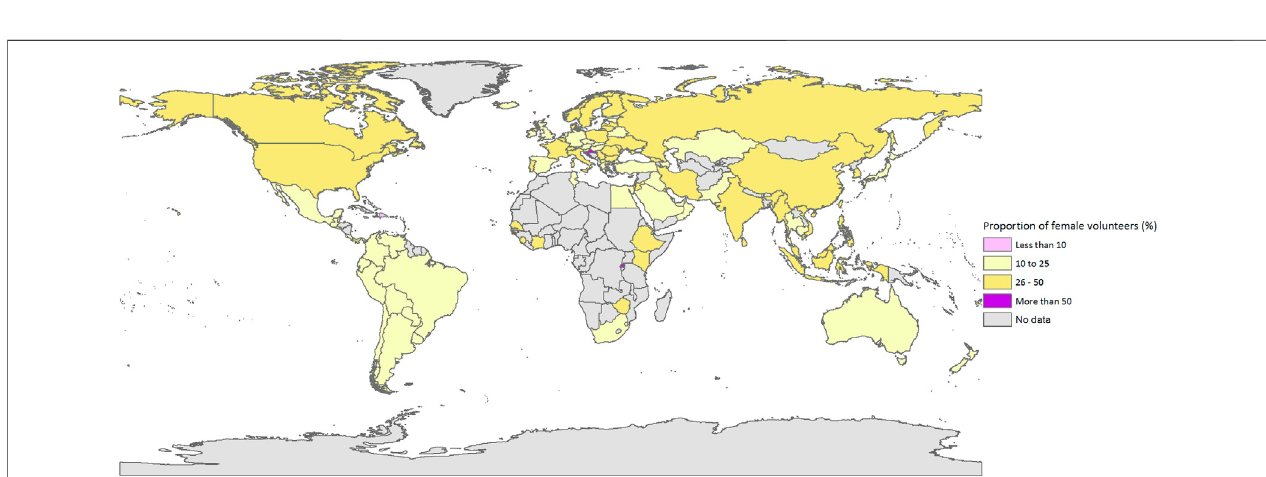
FIGURE 7 | Ratio of female contributors to Zooniverse